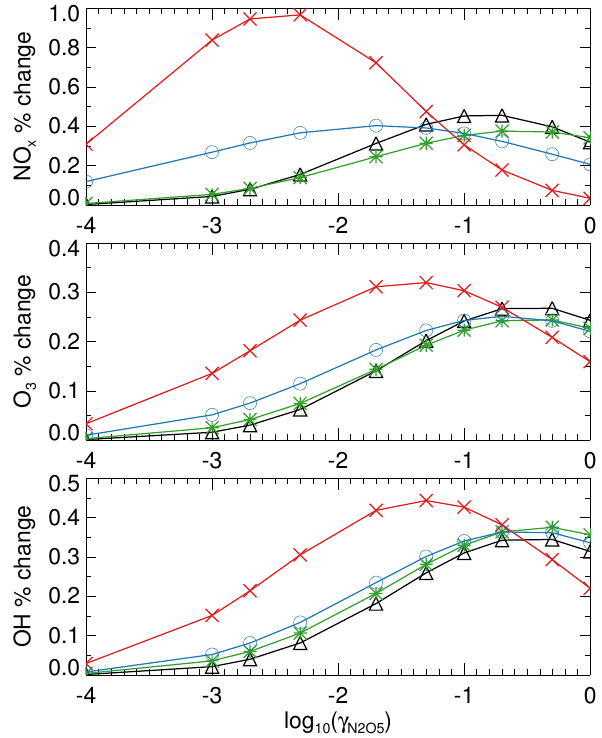
× A (derived Fig. 3. Impact of a 10% reduction in the product γ N 2 O 5 from the fits to the curves shown in Fig. 2) on mean annual burdens of NO x , O 3 , and OH for various γ N values (shown on a log 2 O 5 scale). Northern extra-tropics (90 ◦ N–30 ◦ N) are the red crosses, tropics (30 ◦ N–30 ◦ S) are green stars, southern extra-tropics (30 ◦ S– 90 ◦ S) are black triangles, and global values are shown in blue cir-